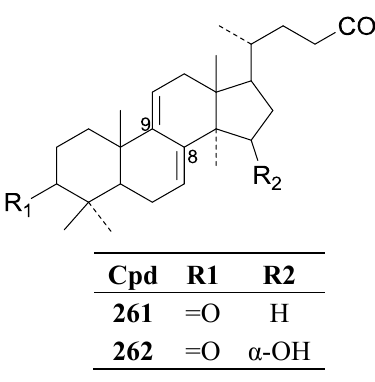
Figure 24. Structures of compounds 261 – 262 .